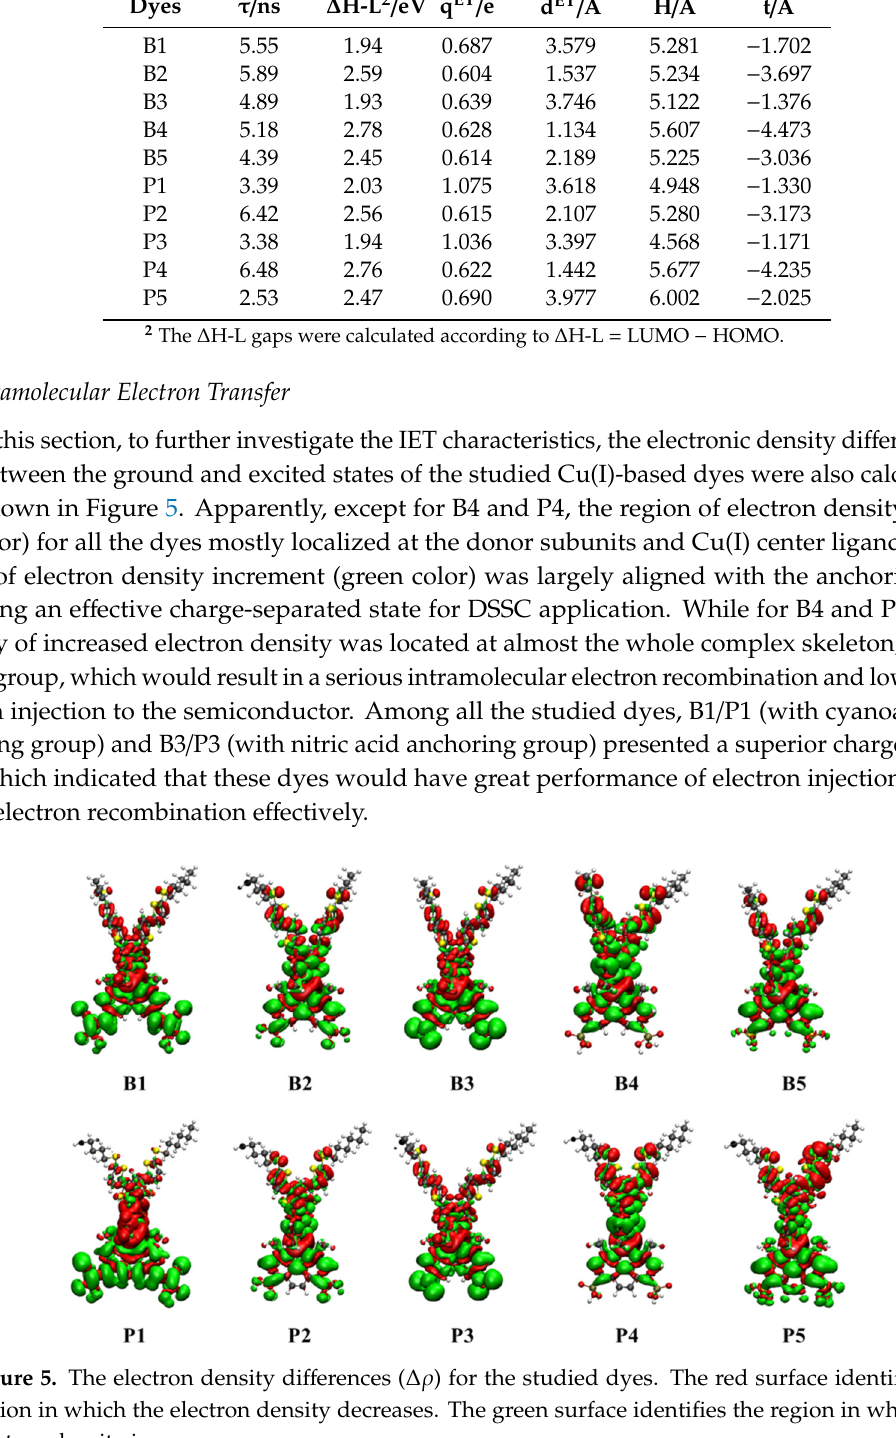
Table 2. The optical properties and intramolecular electron transfer (IET) parameters of the studied dyes. Dyes τ / ns